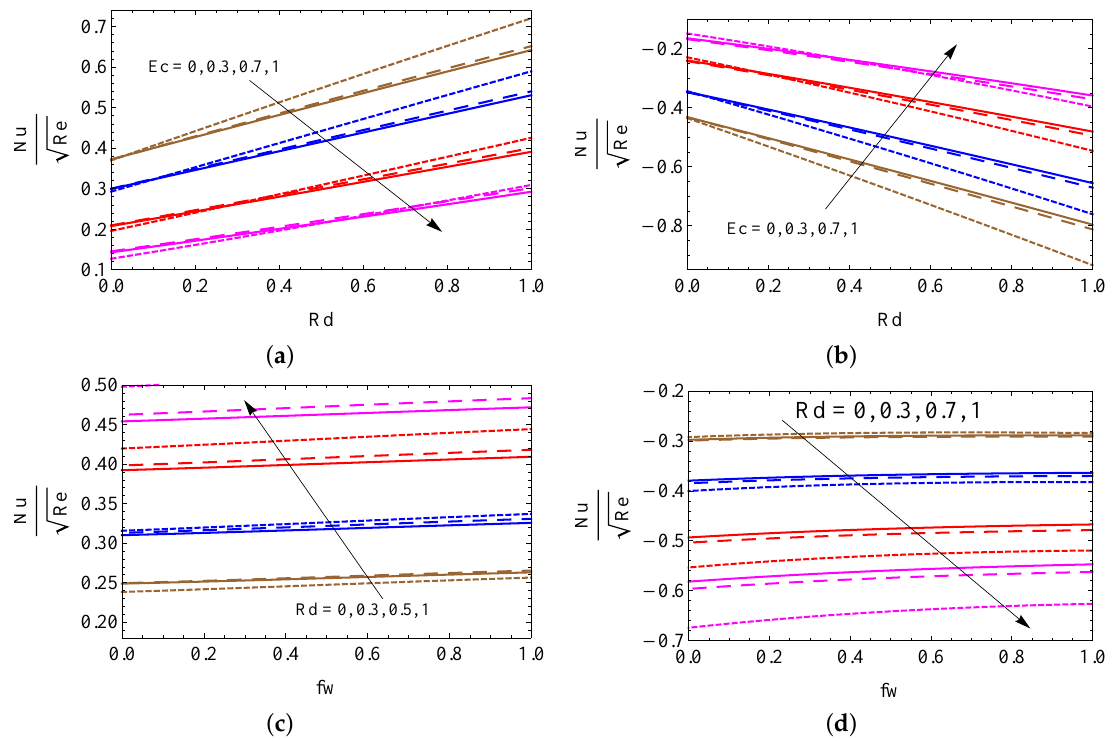
Figure 8. The contrast of LNN for different combinations of Ec and Rd ( a , b ) and Rd and fw ( c , d ) with convective heating ( a , c ) and convective cooling ( b , d ) cases for SWCNTs (solid line), MWCNTs (dashed line) and Al 2 O 3 nanofluid (dotted